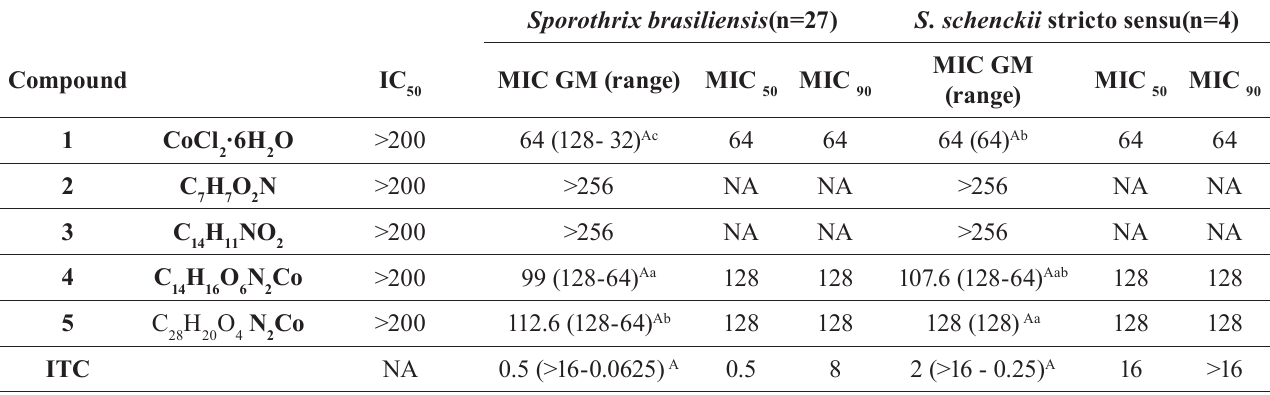
IC : inhibition concentration of 50% of the cells in the cytotoxicity assay. GM: geometric mean. MIC: minimum inhibitory 50 concentration. ITC: itraconazole. NA – not available. Different capital letters correspond to P < .05 for the difference between the MIC values of the Sporothrix species (Kruskal-wallis test); and different small letters correspond to P < .05 for the difference between the Co compounds MICvalues (Friedman